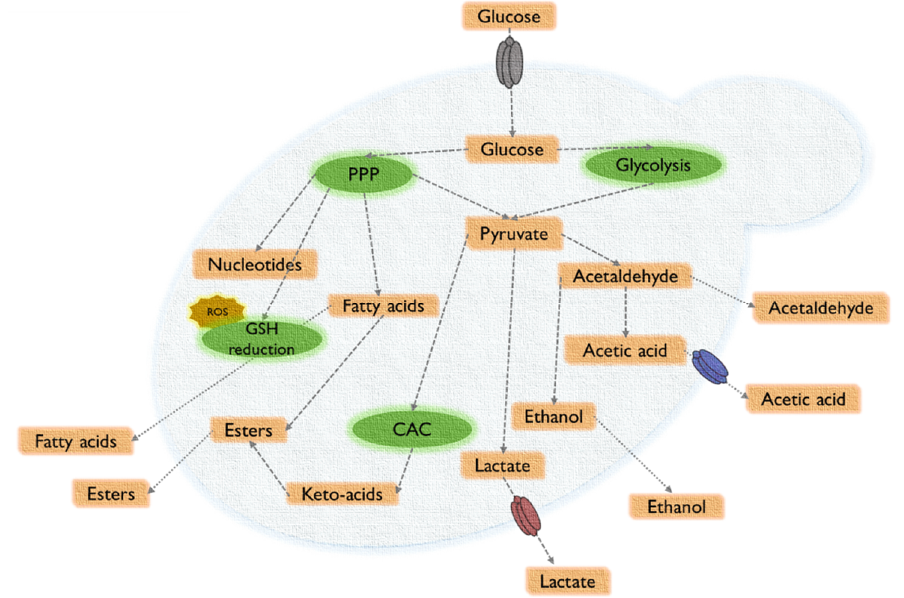
Figure 1. Main metabolic routes in L. thermotolerans under fermentative conditions. Metabolic pro- cesses are indicated in green, while intermediate or final metabolites are indicated in yellow. The presence of specific transporters is indicated in the scheme. PPP: Pentose Phosphate Pathway. GSH: Glutathione. ROS: Reactive Oxygen Species (Oxidative stress) CAC: Citric Acid Cycle. Source: self- made.